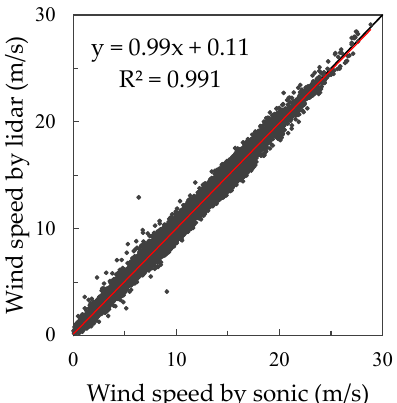
Figure 4. Comparison of 10 min averaged wind speeds observed by Lidar and Sonic at the height of 80 m.